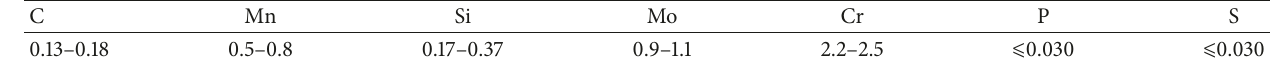
Table 2: Chemical composition of KMN-I (wt.%).